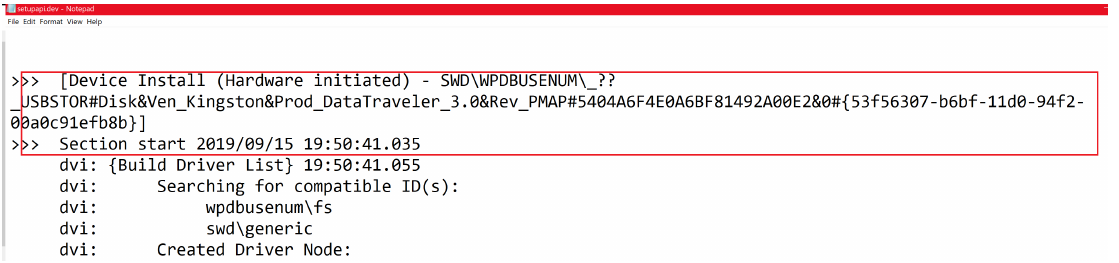
Figure 20. Kingston USB setup information in setupapi.dev log